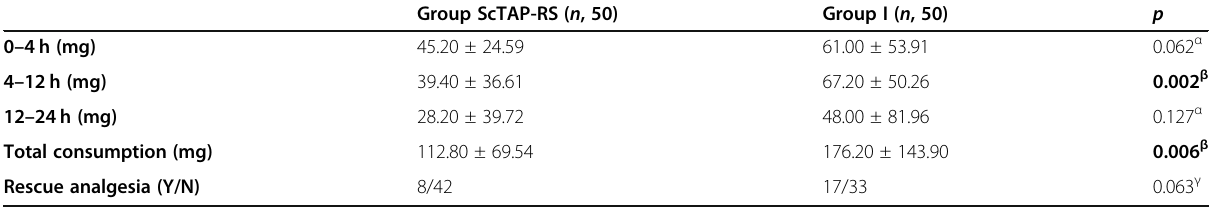
Table 3 The comparison of tramadol consumption between group ScTAP-RS and group I Group ScTAP-RS ( n , 50)